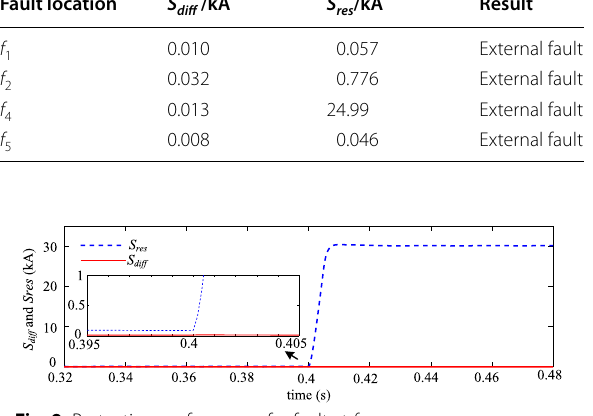
Fig. 8 Active distribution network model with IIDG